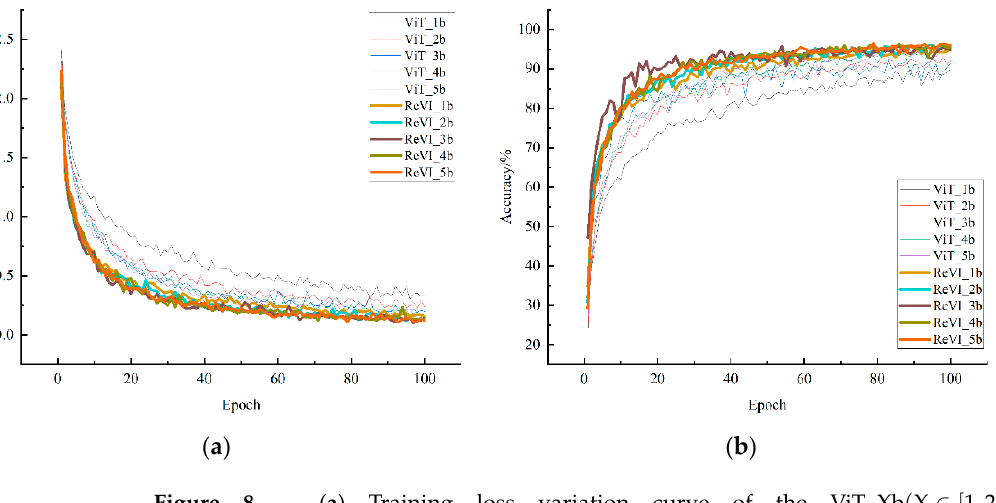
Figure 8. ( a ) Training loss variation curve of the ViT_Xb(cid:4666)X ∈ [1,2,3,4,5](cid:4667) and ReVI_Xb(cid:4666)X ∈ [1,2,3,4,5](cid:4667) ; ( b ) accuracy variation curve of the ViT_Xb(cid:4666)X ∈ [1,2,3,4,5](cid:4667) and ReVI_Xb(cid:4666)X ∈ [1,2,3,4,5](cid:4667). The thin dashed line in Figure 8 shows the variation curve of ViT_Xb(cid:4666)X ∈ [1,2,3,4,5](cid:4667) , and the thick dashed line shows the variation curve of ReVI_Xb(cid:4666)X ∈ [1,2,3,4,5](cid:4667) . Figure 8 shows that the convergence rate of the ReVI_Xb(cid:4666)X ∈ [1,2,3,4,5](cid:4667) model is faster than that of ViT_Xb(cid:4666)X ∈ [1,2,3,4,5](cid:4667) , and the prediction accuracy of the model after convergence is